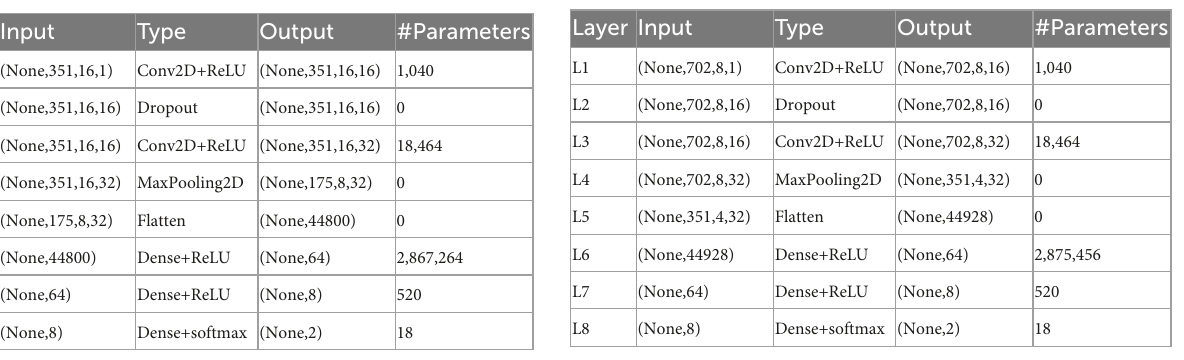
TABLE 2 Convolutional neural network (CNN) structure of two-person serial data